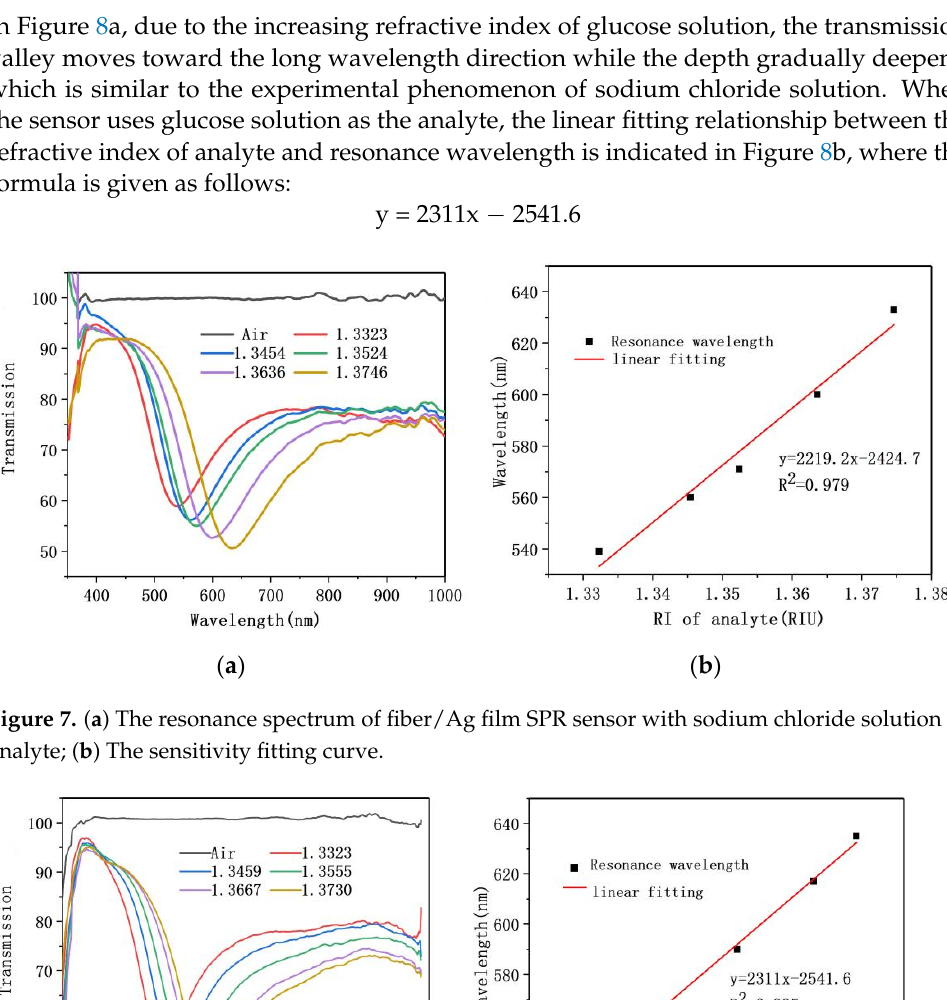
Figure 7. ( a ) The resonance spectrum of fiber/Ag film SPR sensor with sodium chloride solution as analyte; ( b ) The sensitivity fitting curve.